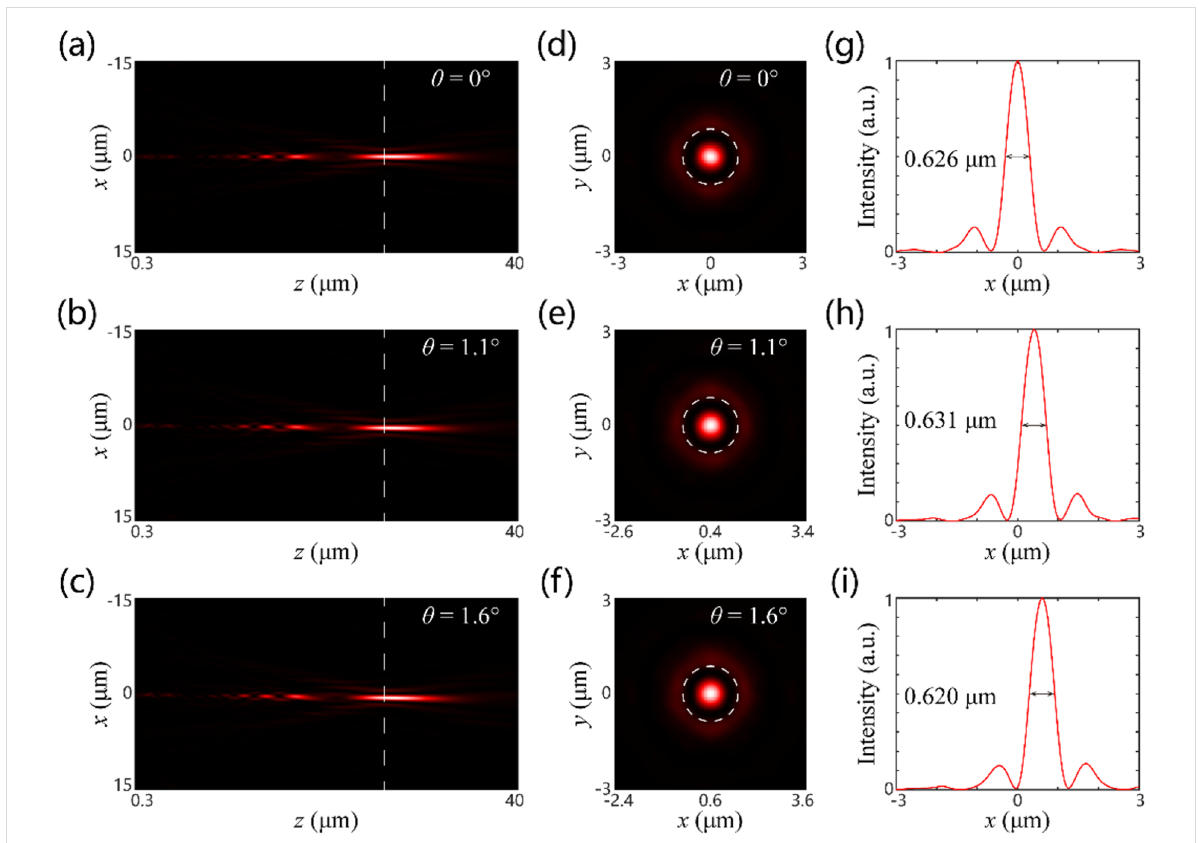
Figure 4: Simulated intensity distributions for different incident angles with RCP incidence corresponding to the SSL with short focal length. (a–c) In- tensity distributions along the propagating direction. The dashed white lines represent the focal plane of the SSL. (d–f) Intensity distributions in the focal plane. The dashed white circles represent the diffraction-limited focal spot (Airy disk). (g–i) Intensity distributions of the sub-diffraction spot along the x